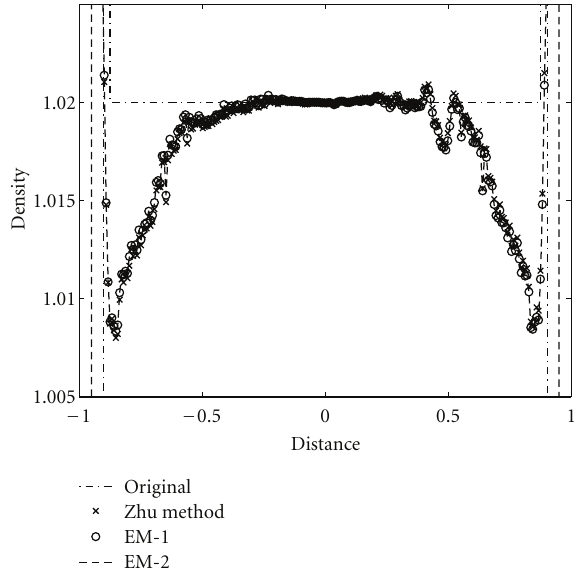
Figure 11: Illustration of axial intensity drop in full-scan recon- structions of Shepp-Logan low contrast phantom, vertical profile of the Shepp-Logan low contrast phantom at z = 0 in Figure 10.